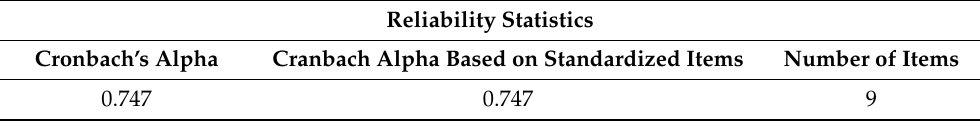
Table 4. Cranbach Alpha coefficient of the survey results of evaluation indicators. Reliability